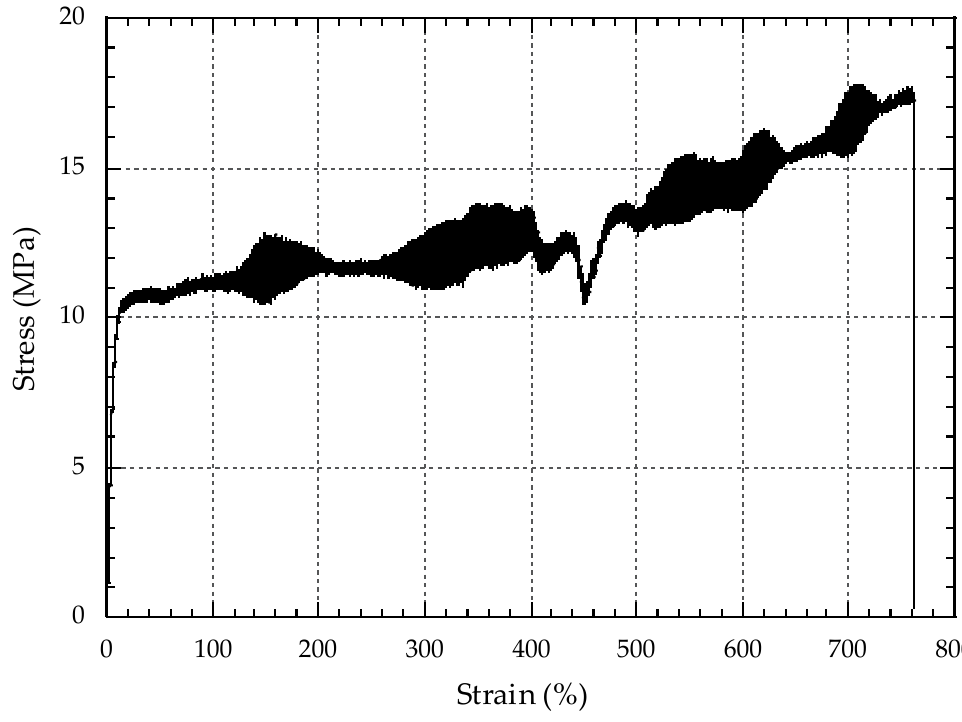
Figure 12. Example of a fibre stress-strain curve.